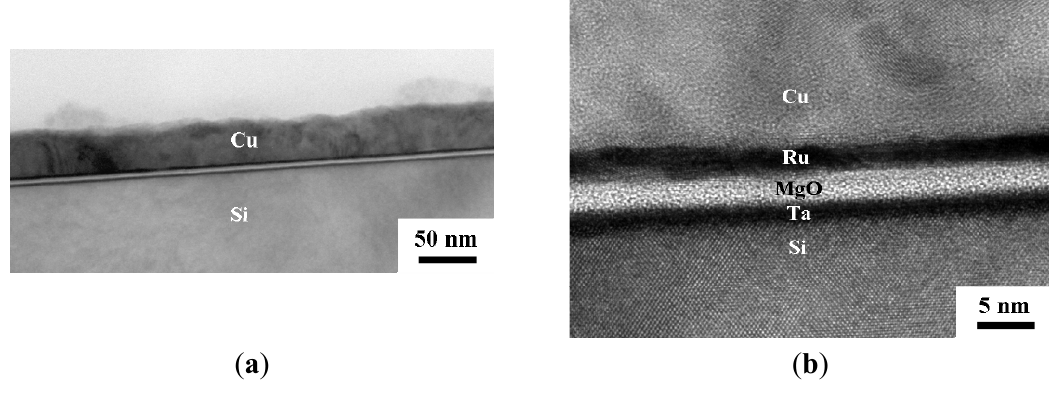
Figure 4. Transmission electron microscope (TEM) cross section views for the MgO (3 nm) sample as deposited at a relatively low magnification ( a ); and at a relatively high magnification (500,000×) ( b ).